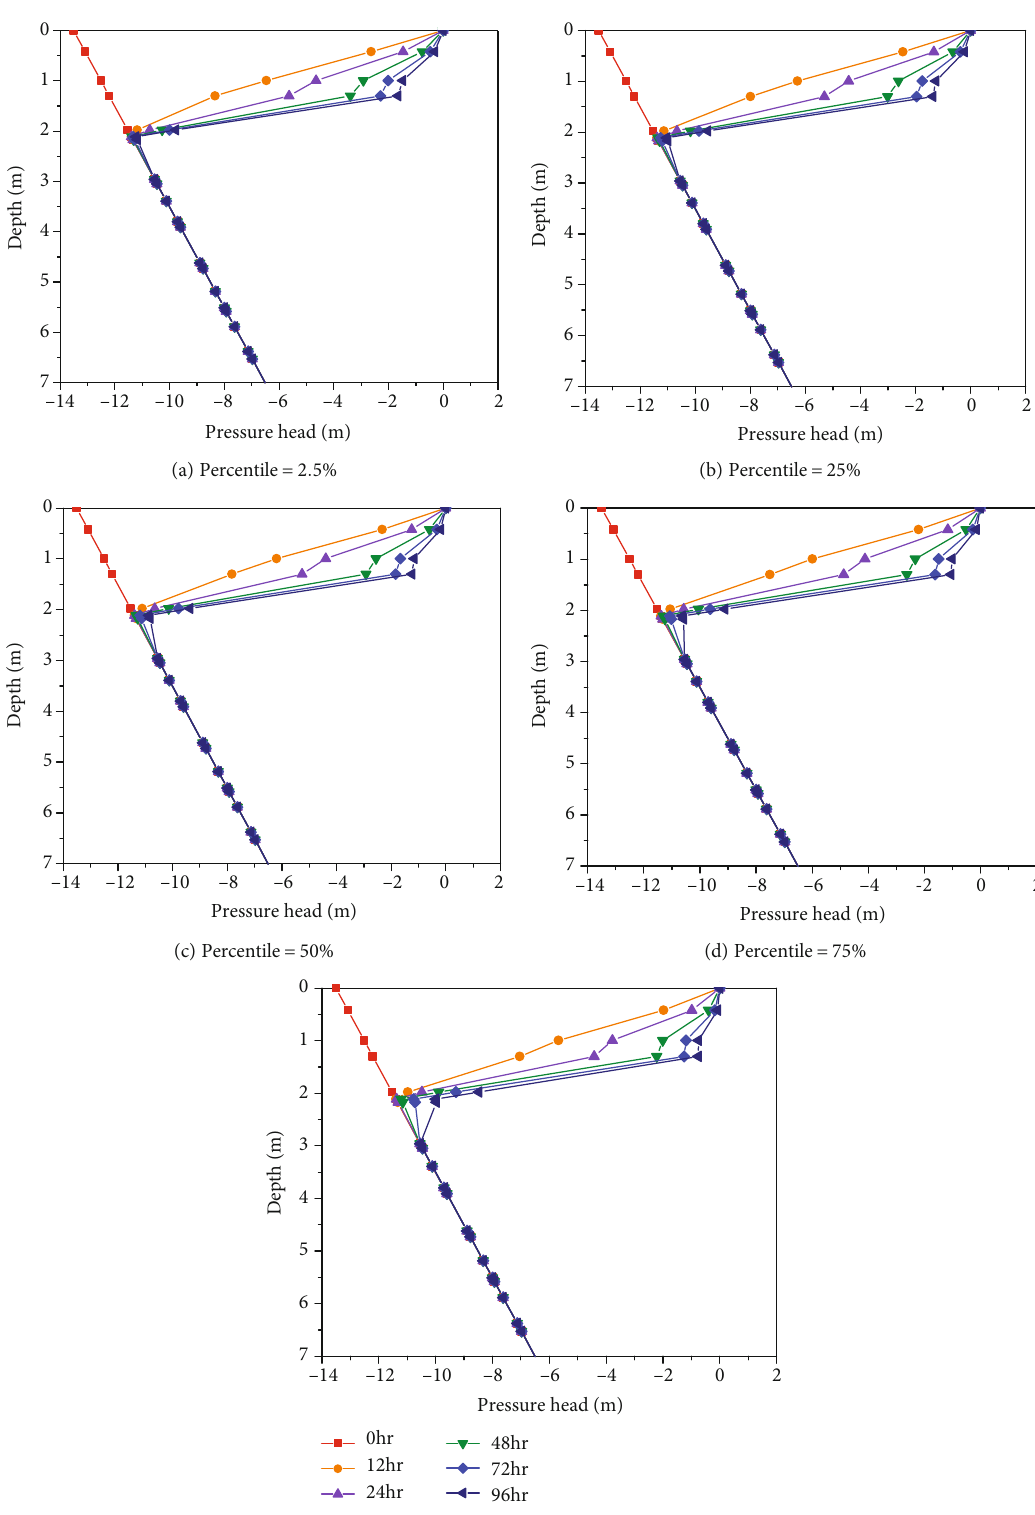
Figure 6: Pressure head at the observation pro fi le with di ff erent percentiles of the SWRC during di ff erent rainfall